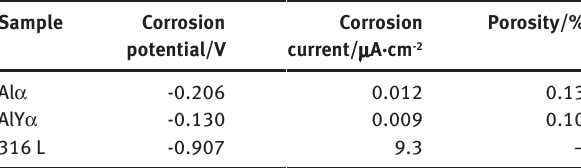
Table 3: Polarization parameters of the plasma oxide coating and 316L stainless